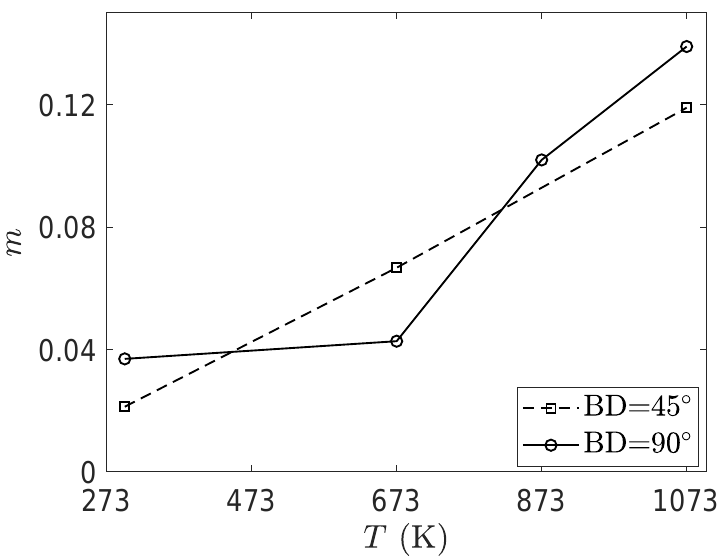
Figure 11. Variation of the strain-rate sensitivity coefficient m according to the